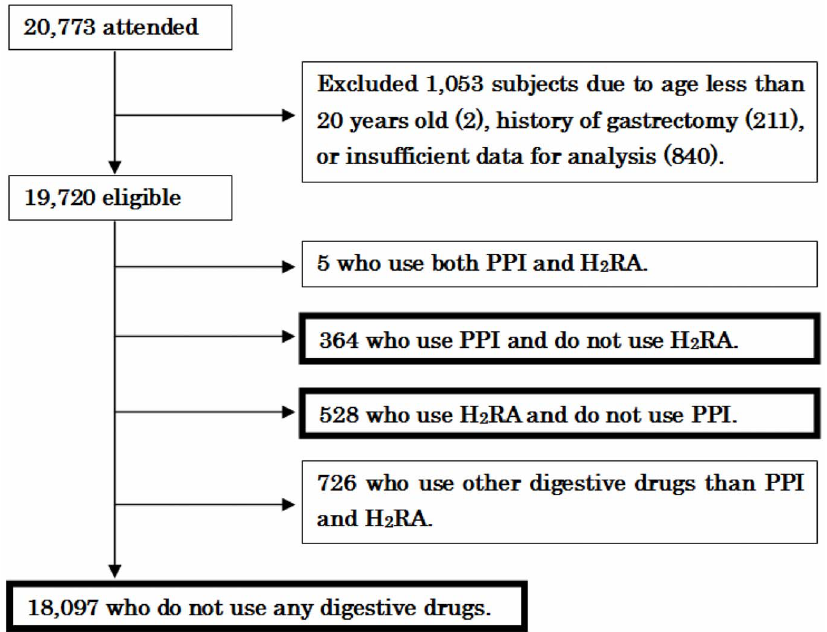
Figure 2. Study recruitment flowchart.